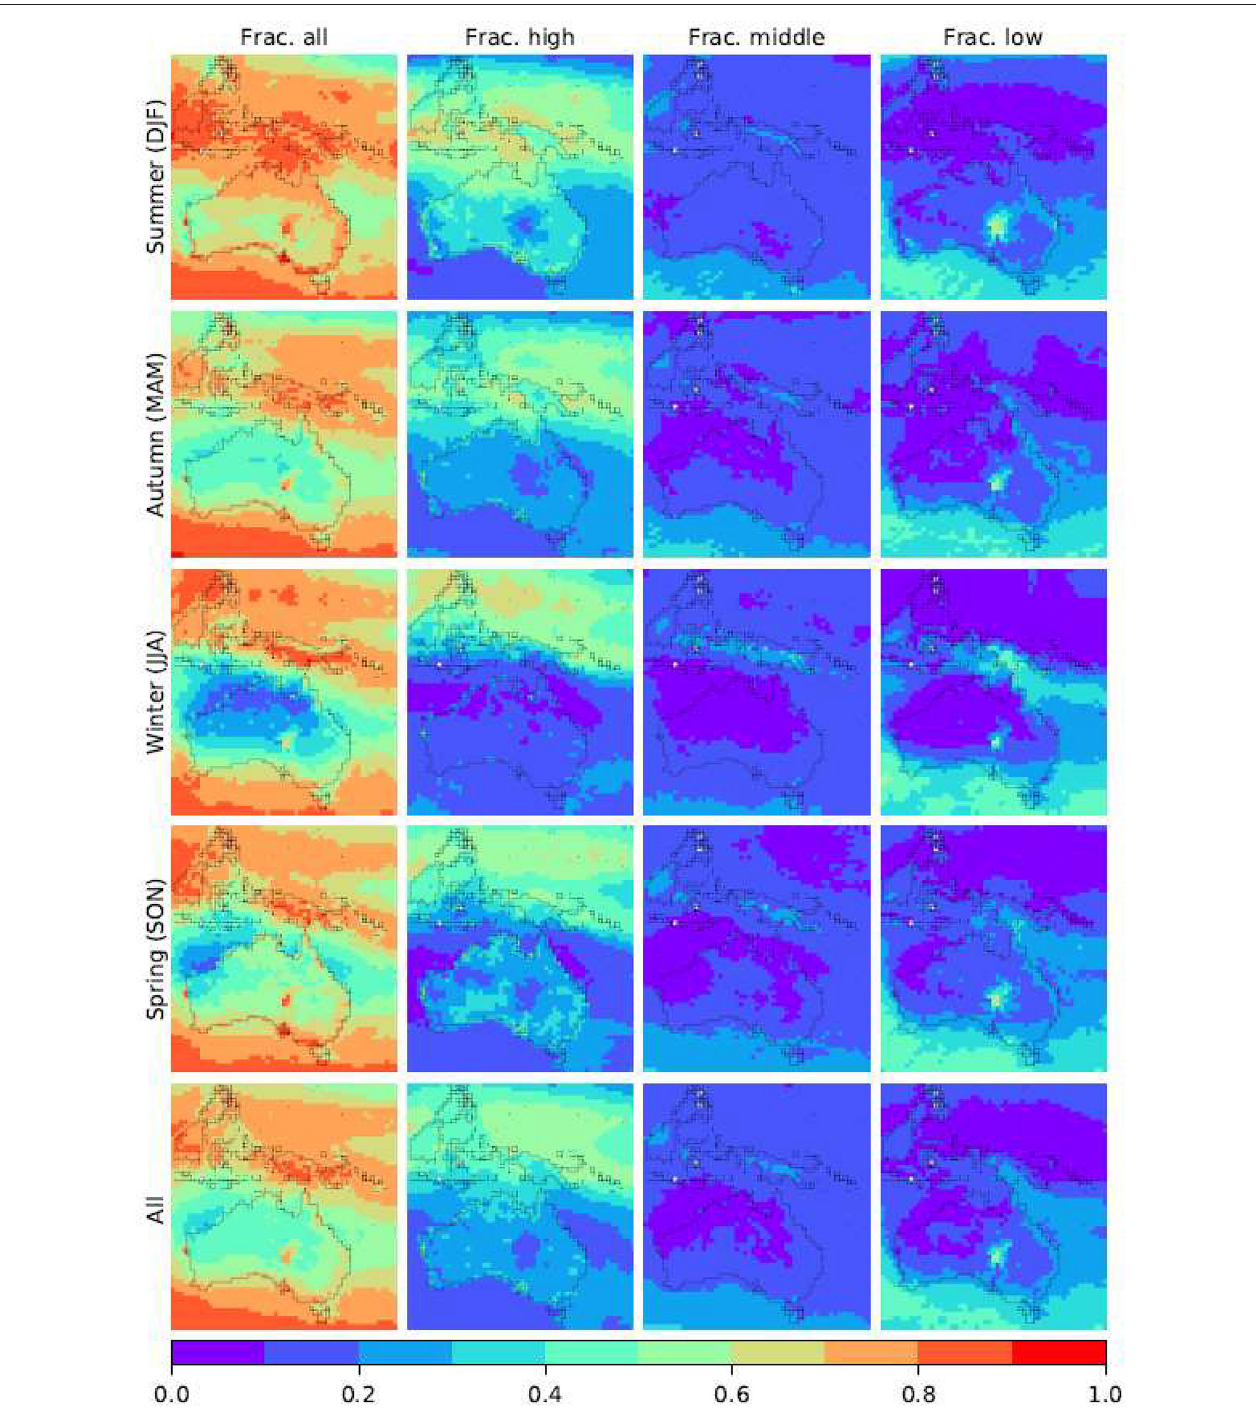
FIGURE 15 | ISCCP climatology. The left-most column (denoted column 1 here) shows cloud frequency for the all cloud types with columns 2–4 (from left to right) show the frequency of the broad cloud types. The austral seasons are provided in rows 1–4 and the yearly mean is given in row 5. Data obtained for the period from Jan 2010 to Jun 2015 for daylight hours (00, 03, and 06